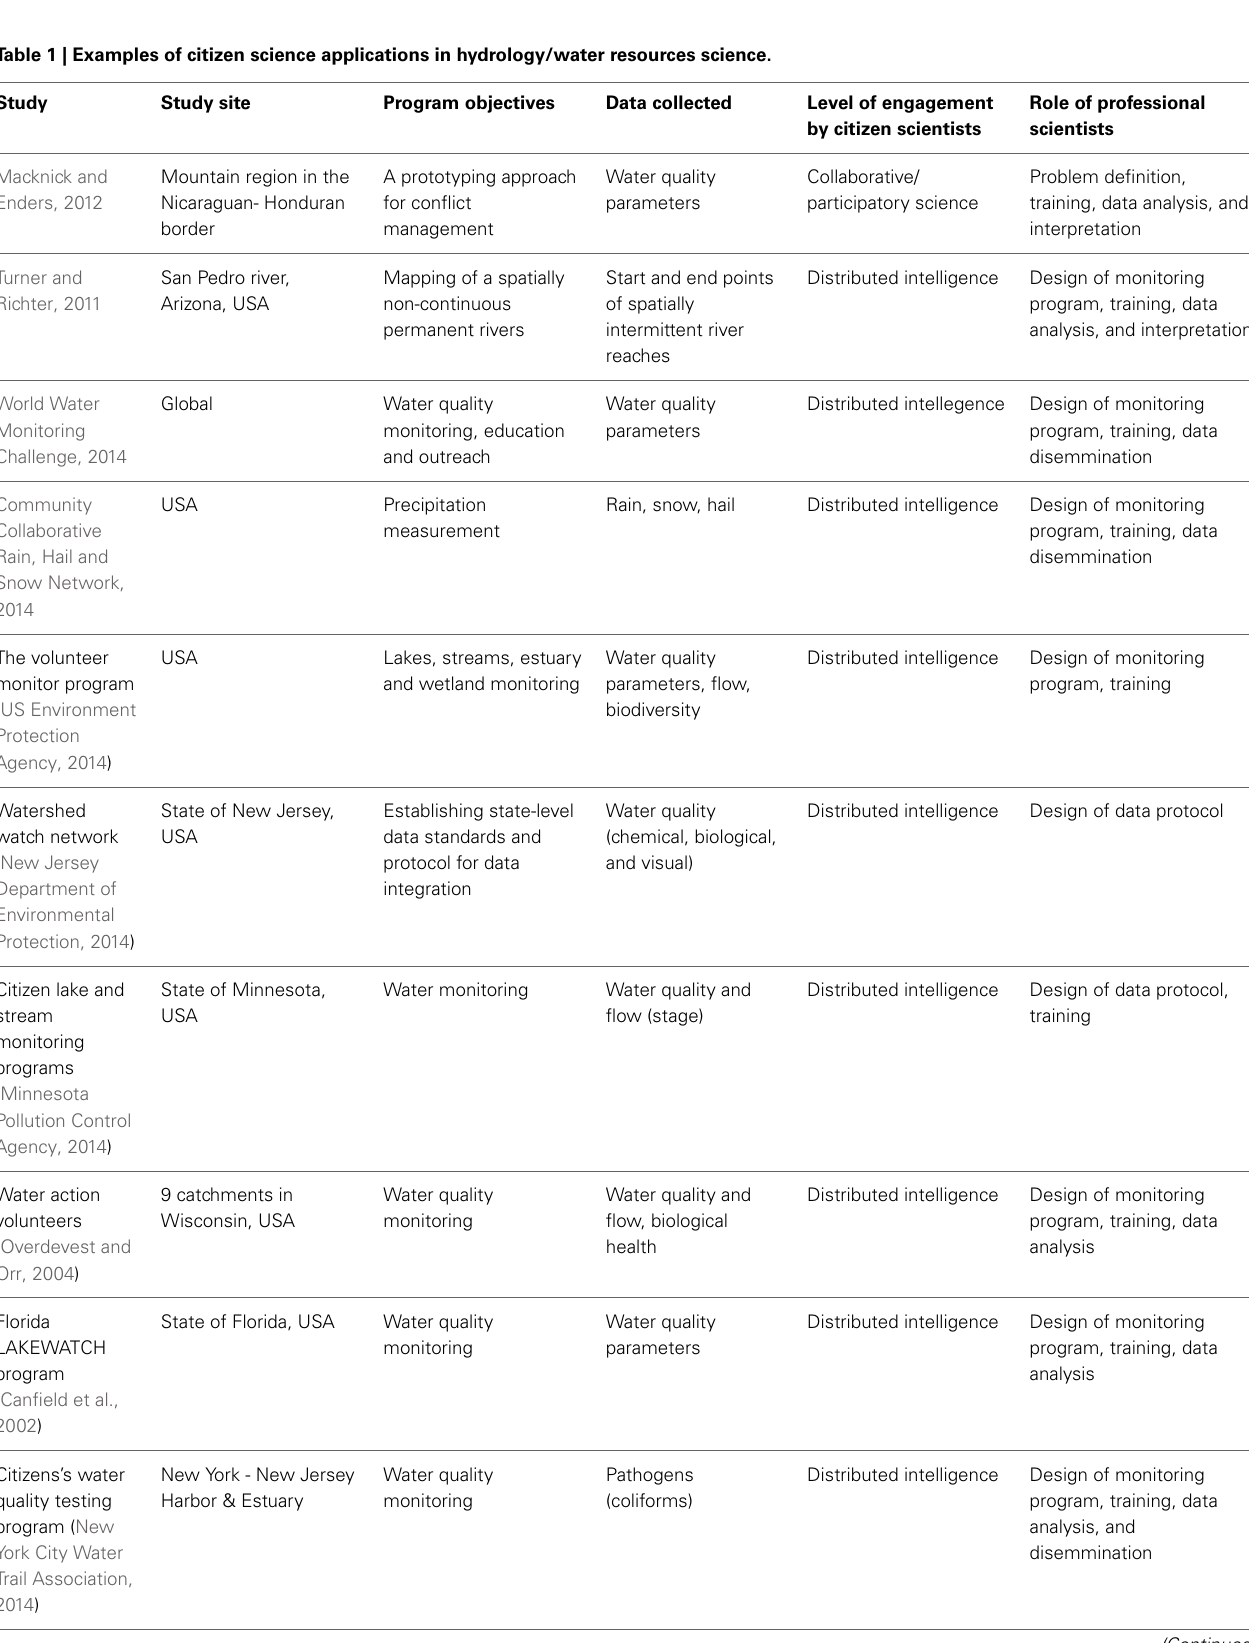
Table 1 | Examples of citizen science applications in hydrology/water resources